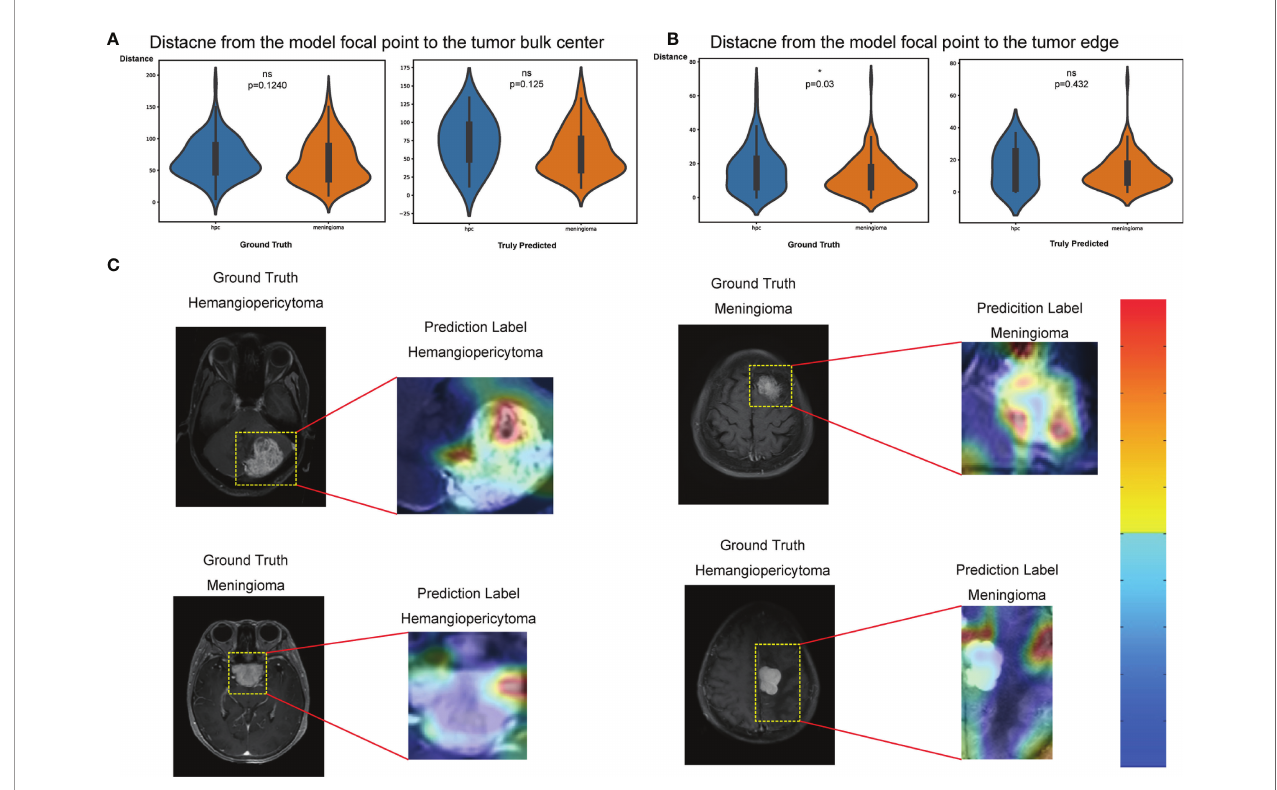
FIGURE 6 | Classi fi cation activation maps. (A) Distance from the model ’ s focal point to the tumor bulk in the ground truth group (left) and truly predicted (right) group, respectively. Wilcoxon rank test, * p < 0.05. (B) Distance from the model ’ s focal point (outside the tumor) to the tumor edge in the ground truth group (left) and truly predicted (right) group, respectively. Wilcoxon rank test, * p < 0.05. (C) Coarse attention maps generated using Smooth Grad-CAM++ for correctly (upper row) and incorrectly (lower row) solitary fi brous tumor/hemangiopericytoma (SFT/HPC) and meningioma classi fi cation. For each pair, the postcontrast T1-weighted scan and the Smooth Grad-CAM++ attention maps (overlaid on scan) have been shown in the cropped images. In activation maps, warmer and colder colors represent high and low contribution of pixels toward a correct prediction, respectively. ns, no signi fi